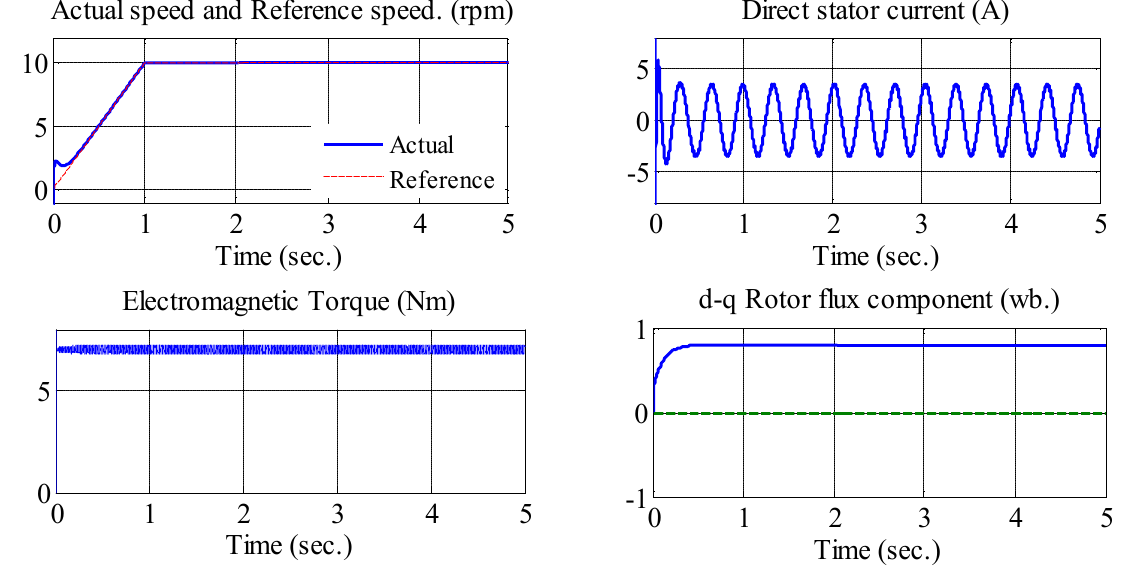
Figure 6. Performance of DFOC for IM drive at low-speed operation.